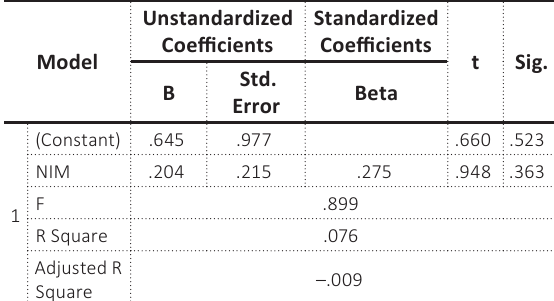
Table 9. Regression analysis testing the relationship between NIM and